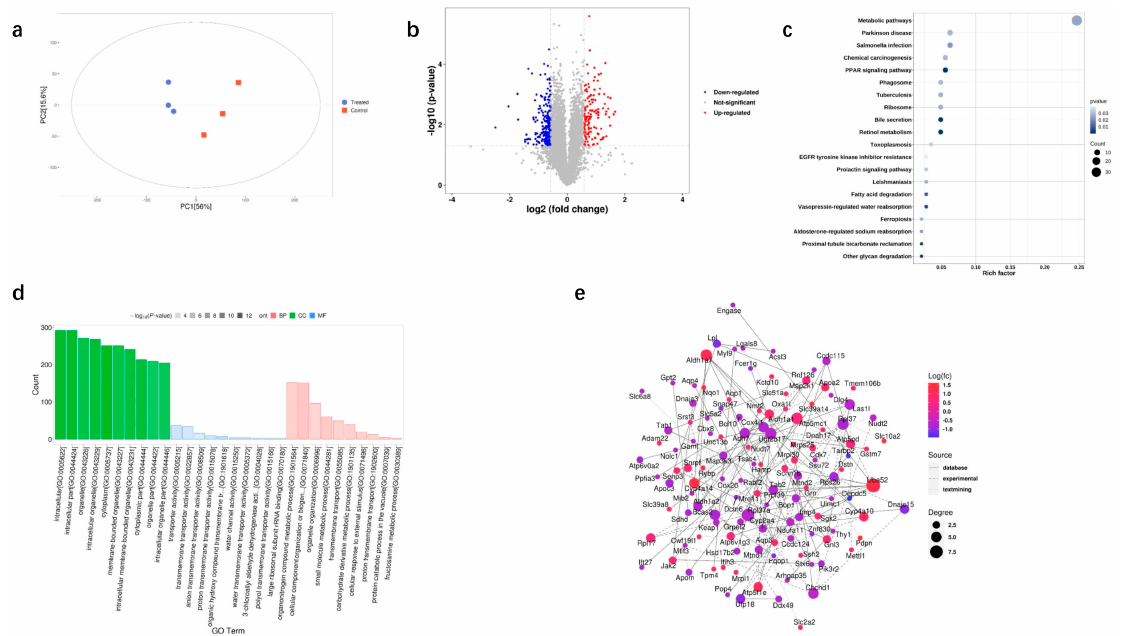
Figure 3. Proteomic pro fi les of control and DQ-treated kidney tissues. ( a ) PCA of the proteomes of DQ-treated and control kidney samples indicated two distinct clusters ( N = 3). ( b ) Volcano plot of di ff erentially expressed proteins (DEPs) between the control and DQ-treated groups. ( c ) Kyoto En- cyclopedia of Genes and ( d ) Genomes pathways of DEPs and their contraction. ( e ) PPI network of the DEPs. The red circles represent signi fi cantly upregulated proteins, and the purple circles repre- sent signi fi cantly downregulated proteins. The size of the circle is positively correlated with the degree of connection.